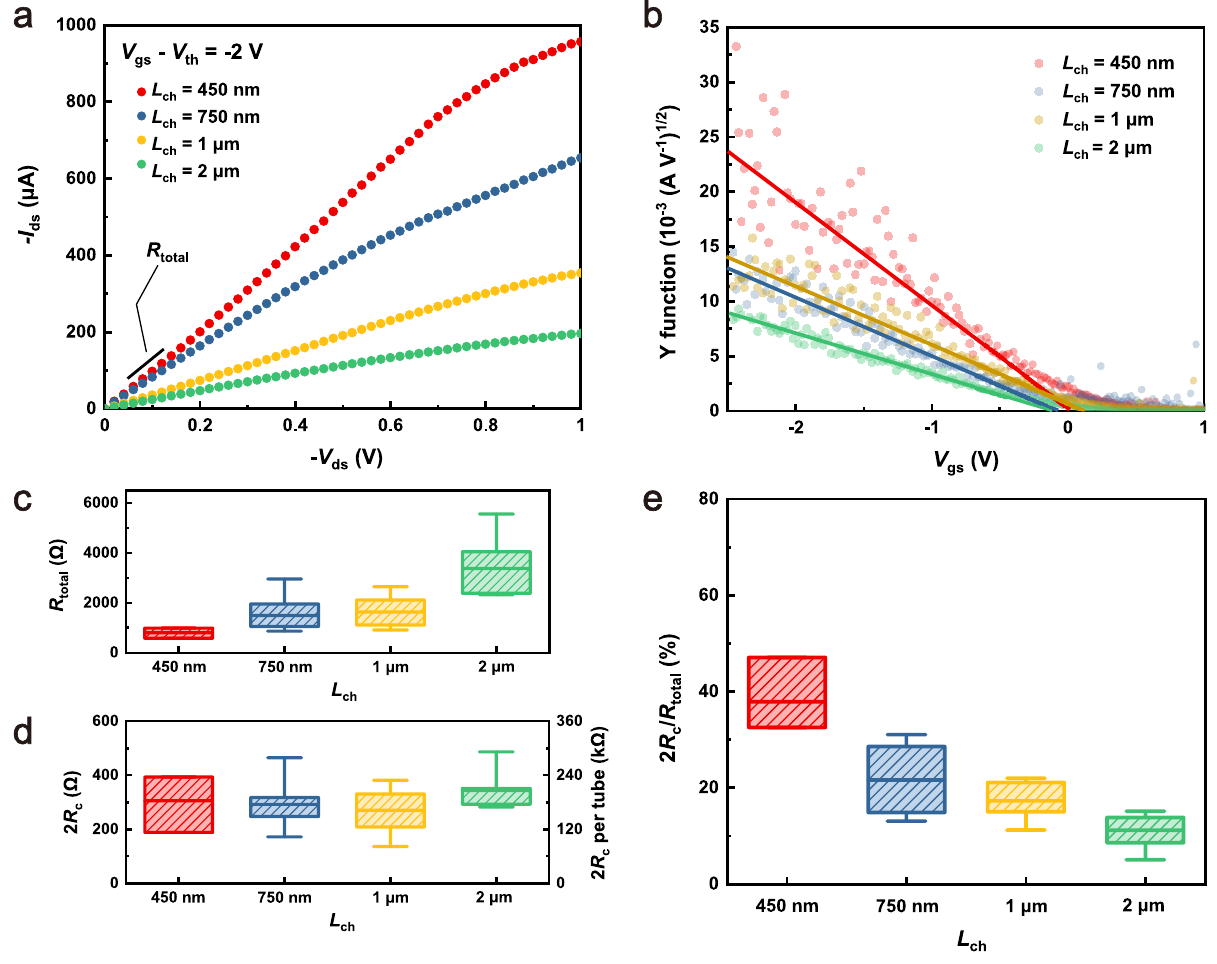
Fig. 4 | The Y function method analysis. a Output characteristics of representa- tive TFTs with different L ch . V gs – V th is used in data analysis to minimize the in fl uence of V th variation. b Calculated Y function for the devices shown in a as a function of V gs . The extracted c device total resistance R total and d contact